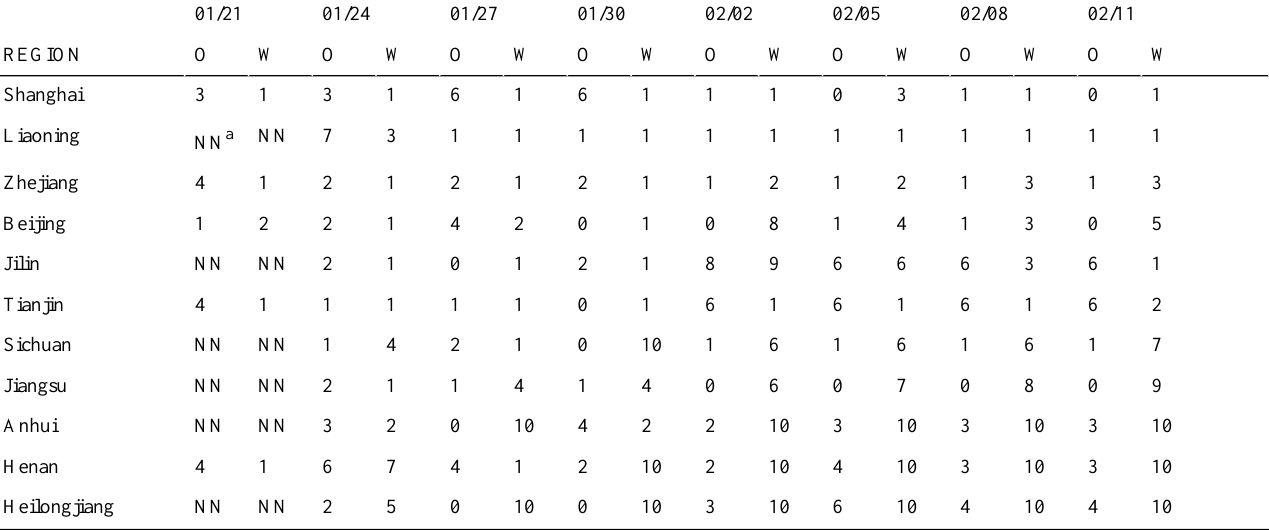
Table 2. OFFSET (O) and WINDOW (W) values from 11 REGIONs between January 21, 2020 and February 11, 2020.